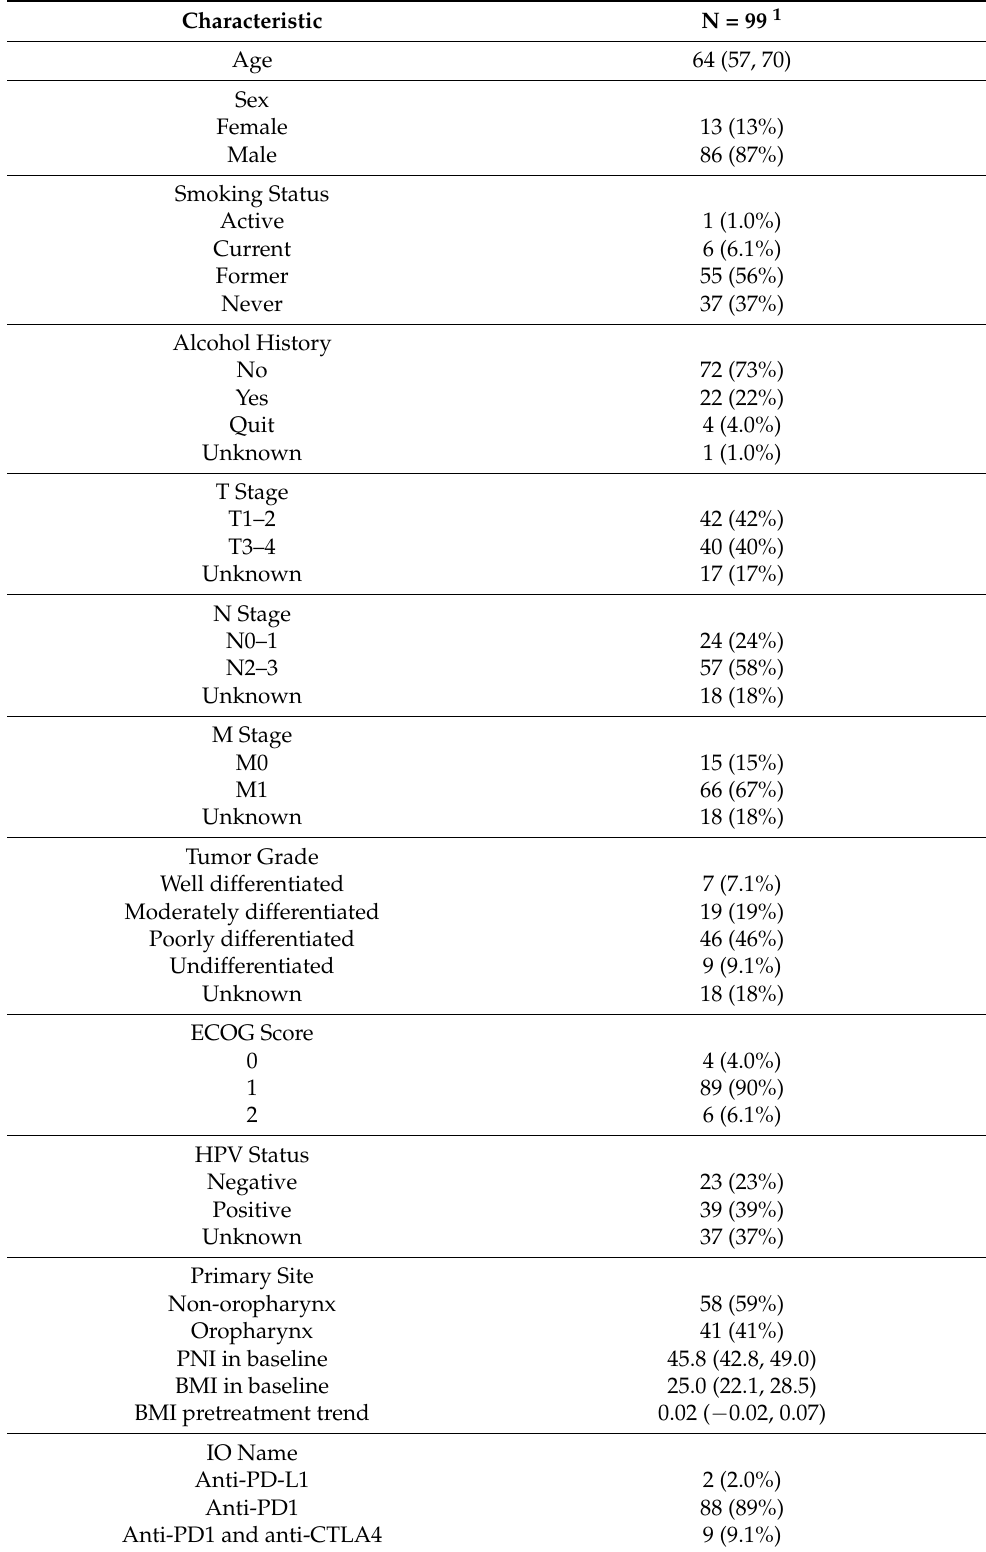
Table 1. Clinical and demographic characteristics of the